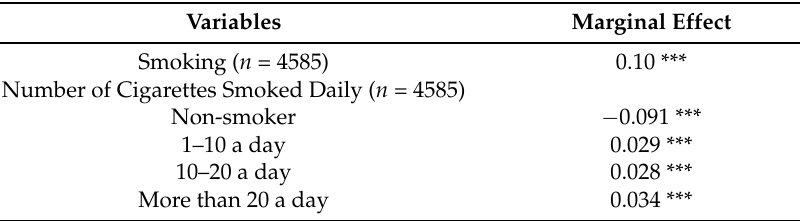
Table 3. Marginal effects of unemployment rate on smoking